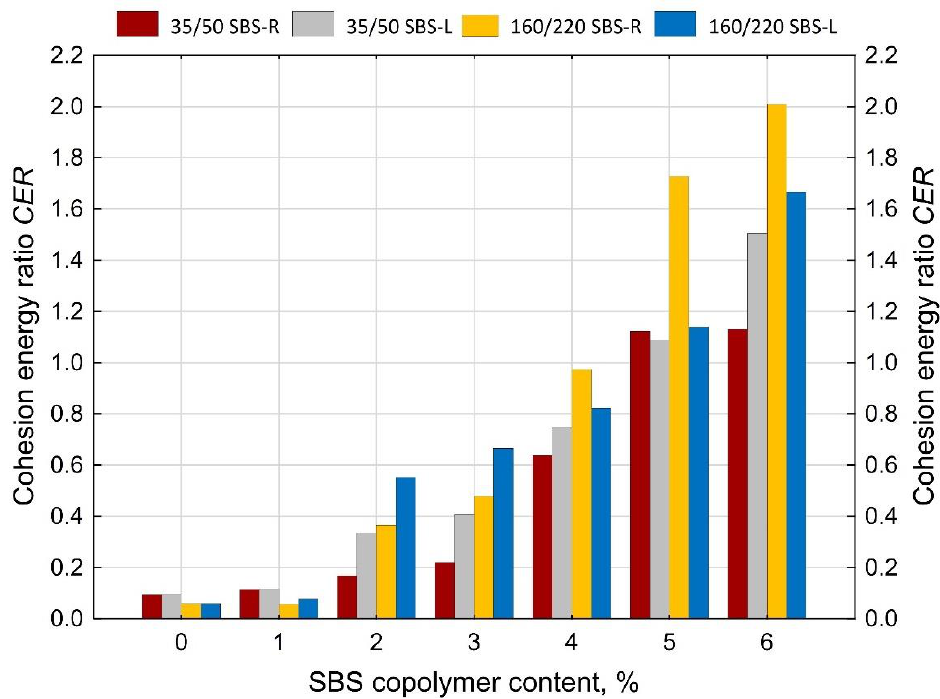
Figure 20. Values of the cohesion energy ratio ( CER ) done on the samples of polymer-modified bitumens in the force ductility test, calculated using Equation (5).